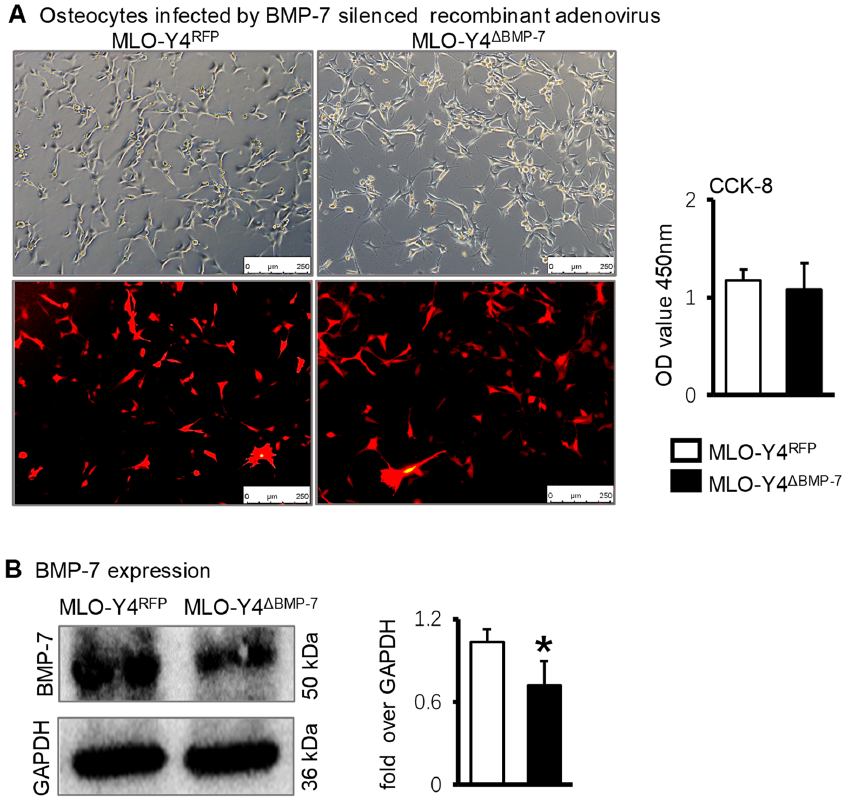
Figure 5. The construction of osteocytes silencing BMP-7. ( A ). Fluorescence image and proliferation of MLO-Y4 after transfection of Ad-siBMP-7. ( B ). BMP-7 protein expression in MLO-Y4 cells after silencing BMP-7 based on Western blotting results. * p < 0.05, compared with MLO-Y4 RFP group. Subsequently, BMP-7-silenced MLO-Y4 cells were cocultured with ST2 cells in a 1:4 ratio for 3 days. Compared with ST2+MLO-Y4 RFP cells, ALP staining and ALP activity (Figure 6A), and gene expression of osteogenic markers were significantly decreased in ST2+MLO-Y4 Δ BMP − 7 cells (Figure 6B). These results showed MLO-Y4 cells silencing BMP-7 inhibited the osteogenic differentiation of ST2 cells in the MLO-Y4 environment.